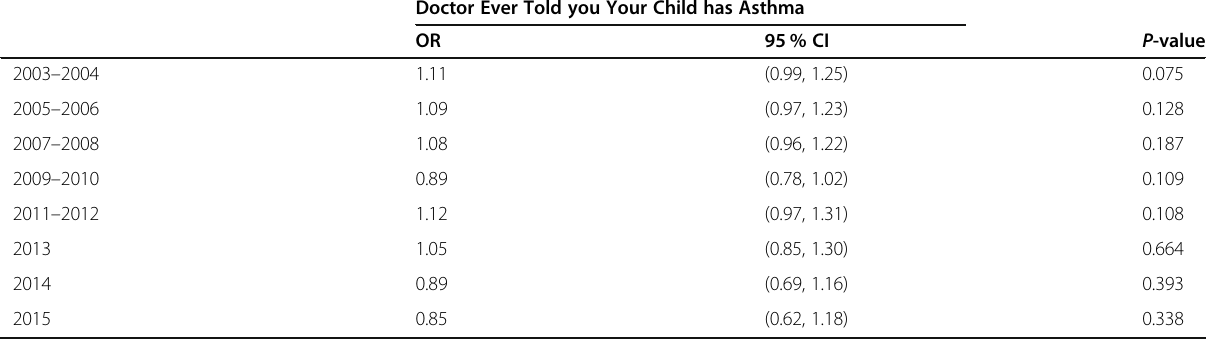
Table 2 Logistic Regression for asthma diagnosis ( n = 61,625) (Continued)